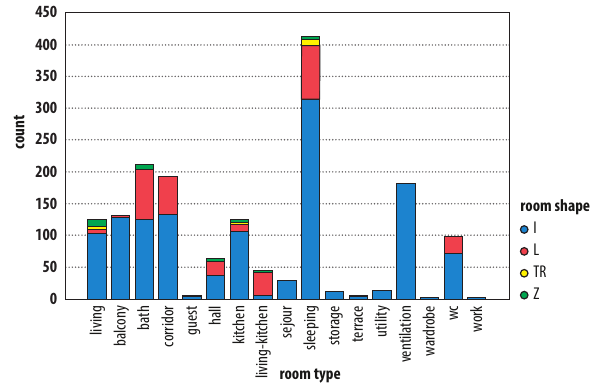
Figure 9. The distribution of functional use with regard to room shapes.